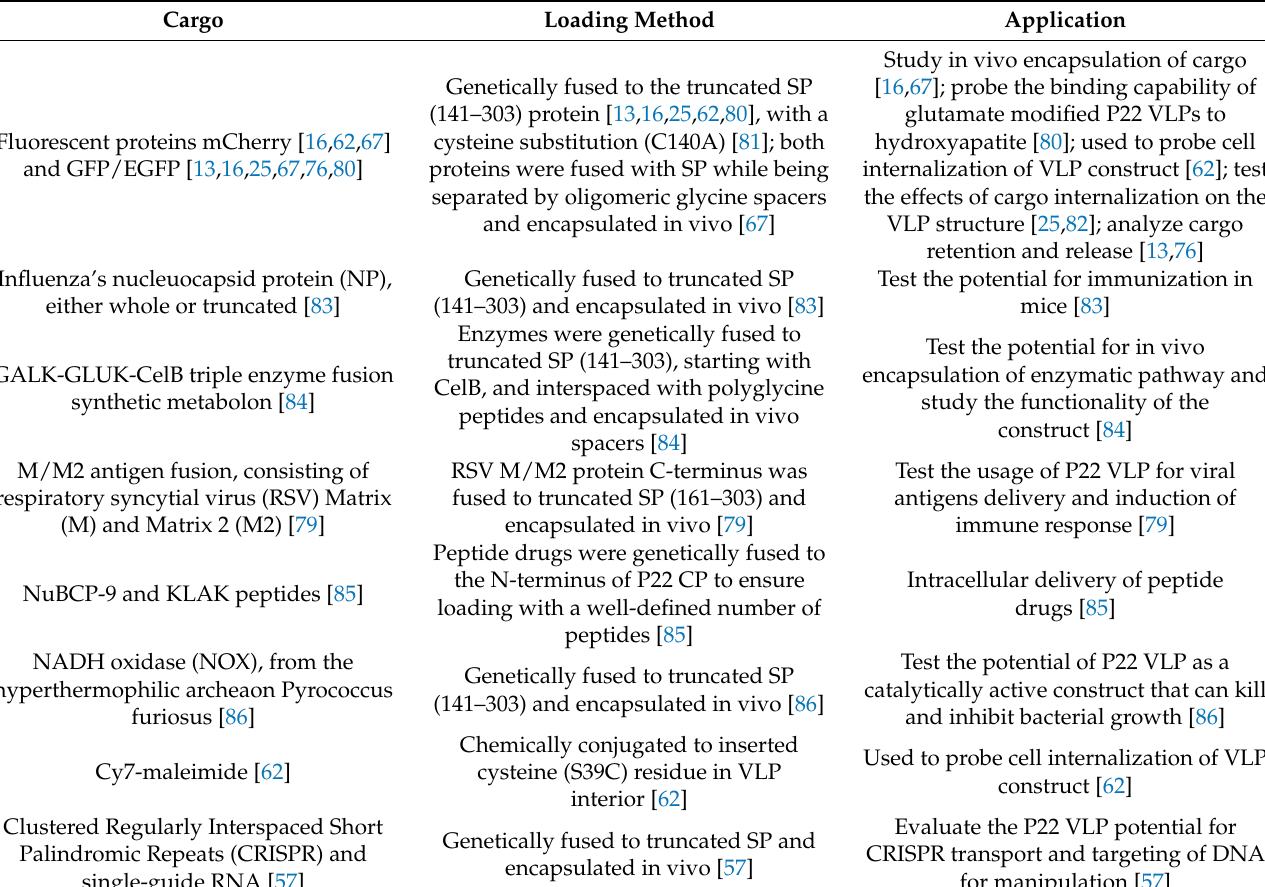
Table 1. The diverse types of cargo that have already been internalized using P22 VLP and the method used for